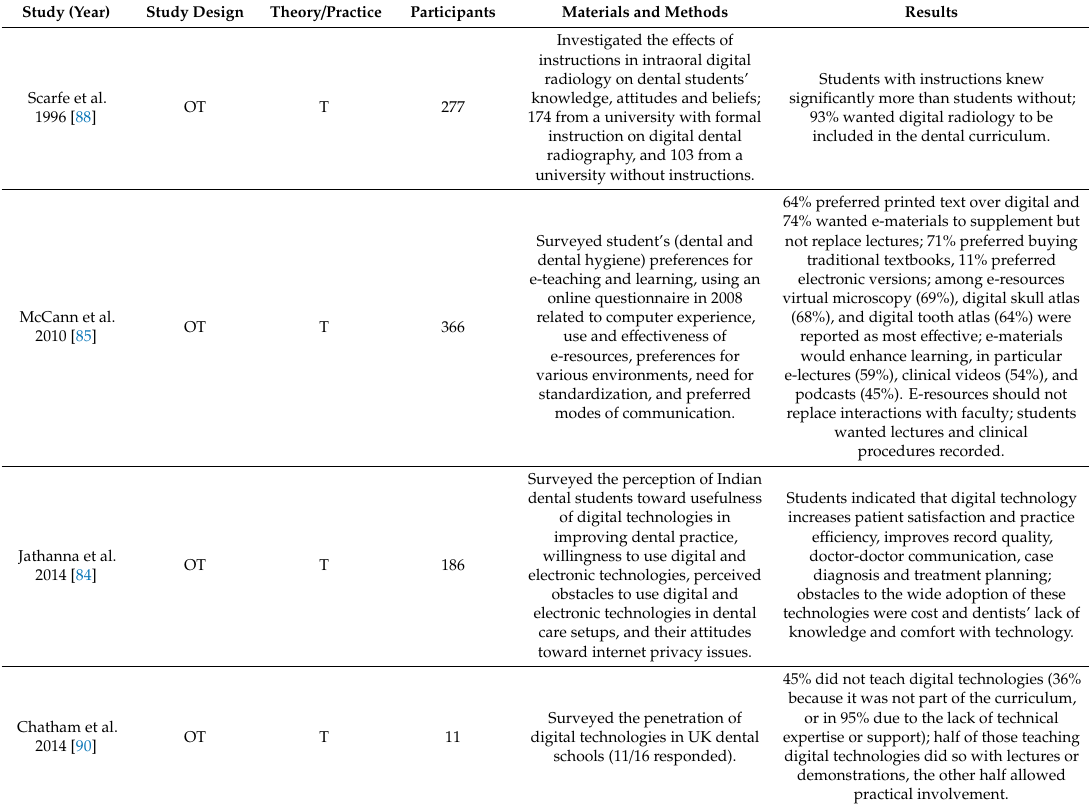
Table 6. Surveys related to digital education ( n =